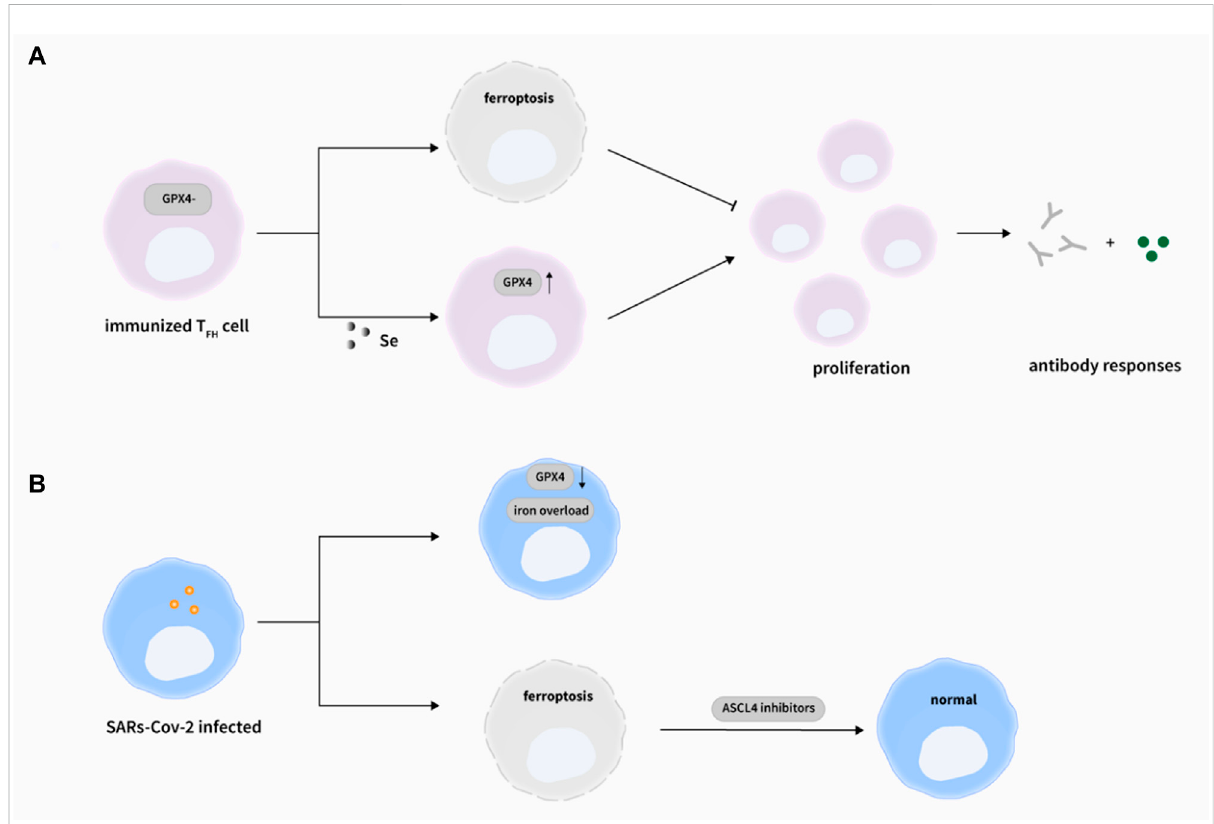
FIGURE 3 Ferroptosis and viral infections. (A) The deletion of GPX4 in T cells selectively abrogated T FH cells functions via ferroptosis in immunized mice. Importantly,seleniumsupplementationcloudenhanceGPX4expressioninTcells,promotingT FH cellproliferationandboostingantibodyresponses inimmunizedmice.(YaoY.etal.,2021). (B) DuringSARs-Cov-2infection,theGpx4mRNAlevelwasdecreased(Wangetal.,2021a)andironoverload was observed (Zhou C. et al., 2020), and the induction of ferroptosis by SARS-Cov-2 could be rescued by ASCL4 inhibitors (Kung et al.,